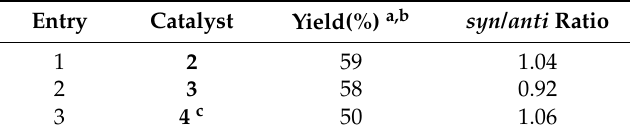
Table 2. Cyclopropanation of styrene catalyzed by 2 , 3 and 4